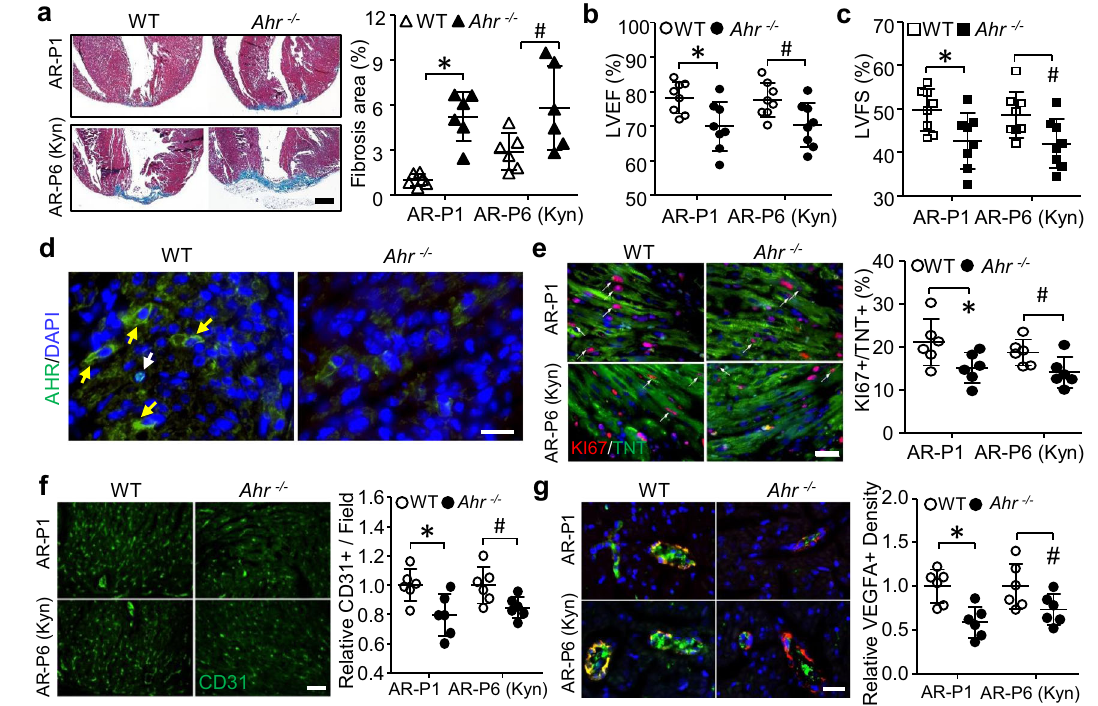
Fig. 5 | Ahr deletion impairs neonatal heart regeneration. In one set of experi- ments, Ahr − / − and wild-type mice underwent apical resection (AR) surgery at P1. In another set of experiments, Ahr − / − and wild-type mice were intraperitoneally injected with Kyn at 100mg/kg every other day from P1 to P28 and underwent AR surgeryatP6. a – c MicewerecollectedatP28forthecardiac fi brosisformationand function analysis. a Representative images and quantitation of fi brosis area by Masson staining ( n =6/group. * P =0.0001, # P =0.0422). b , c Echocardiography analysis of LVEF ( b , * P =0.0140, # P =0.0258) and LVFS ( c , * P =0.0253, # P =0.0283) ( n =8/group). d – g , on day 4 after the surgery, the expressions of AHR, KI67, CD31,